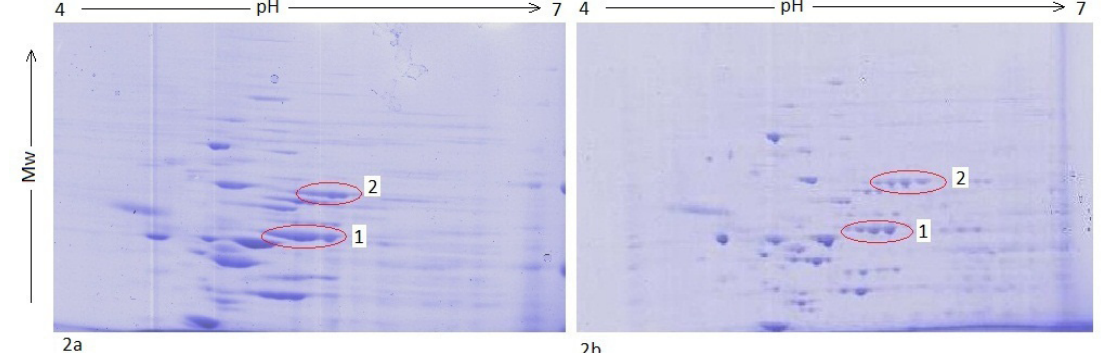
Figure 2. The image of 2D PAGE separation of nuclear proteins isolated from the MCF 7 cell line, (a) gel solidification time of 1 hour and (b) a solidification time of 24